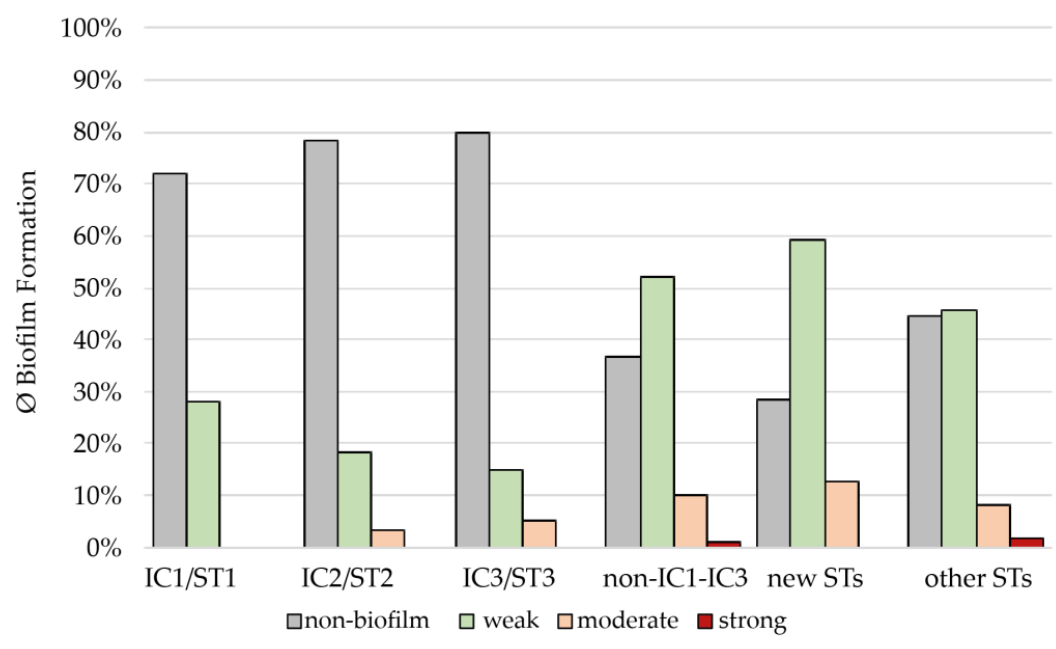
Figure 3. Occurrence of the individual classes (non-biofilm, weak, moderate, and strong biofilm) of the 78 equine A. baumannii isolates based on their determined STs or ICs. New STs = ST1723-ST1744 (n = 22 isolates); other STs = STs not belonging to ST1, ST2, ST3, or new STs (n = 28 isolates); all p -values > 0.1, except for other STs ( p < 0.05).